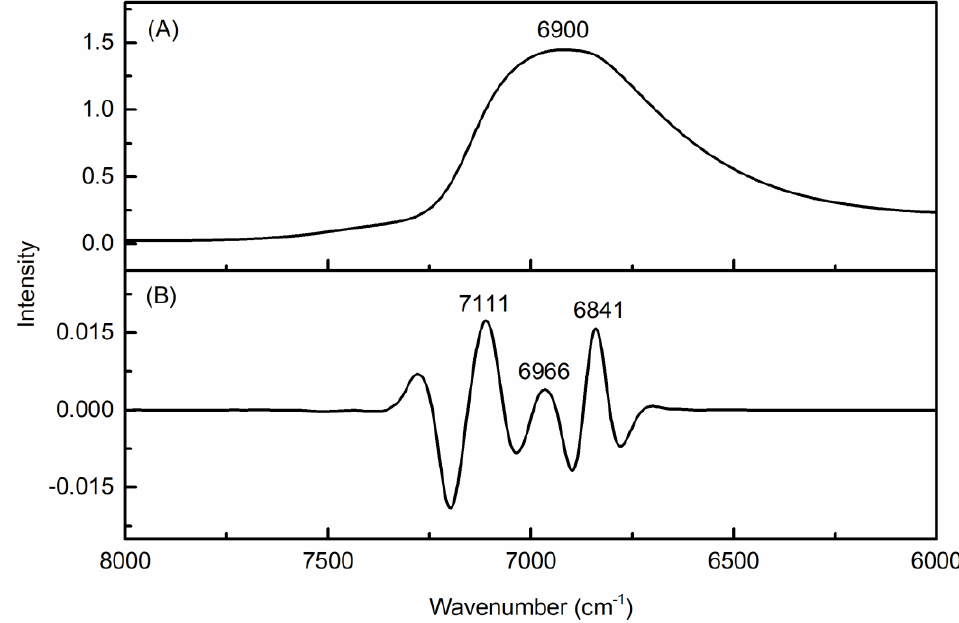
Figure 3. NIR spectrum ( A ) of water in the spectral range 8000 – 6000 cm − 1 and the transformed spectrum by CWT with Sym6 wavelet filter ( B ).